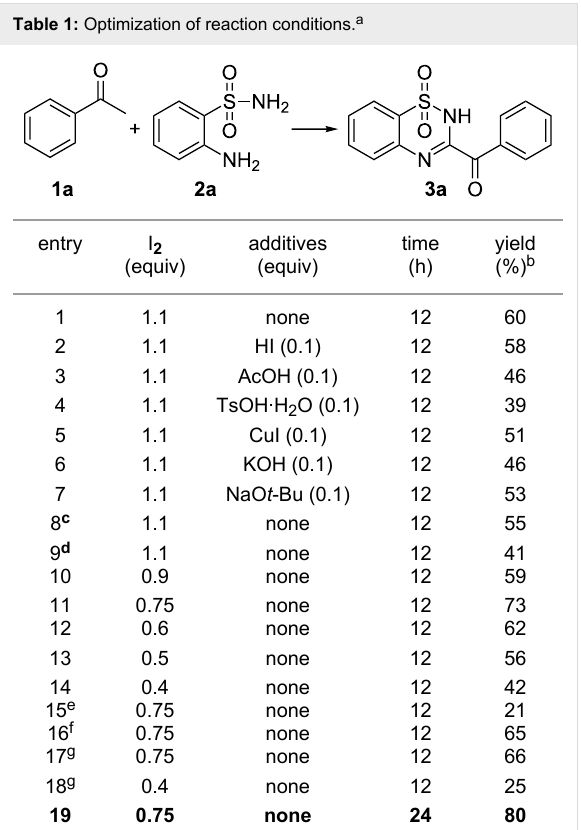
Table 1: Optimization of reaction conditions.